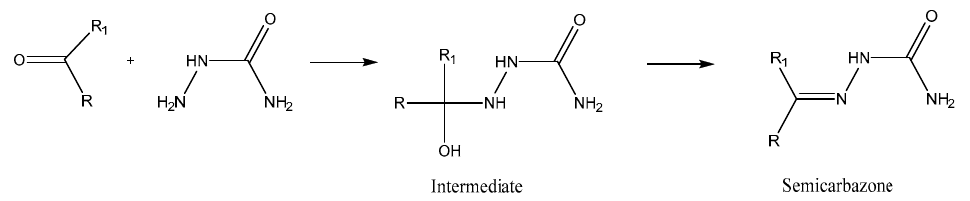
Figure 17. The condensation of a carbonyl group with a semicarbazide group to form a semicarba-